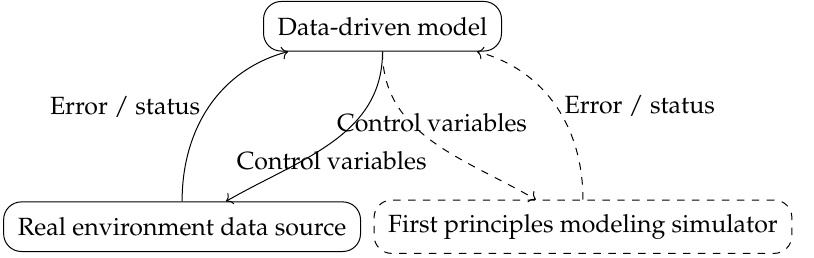
Figure 1. The relation between data-driven method and first-principles modeling